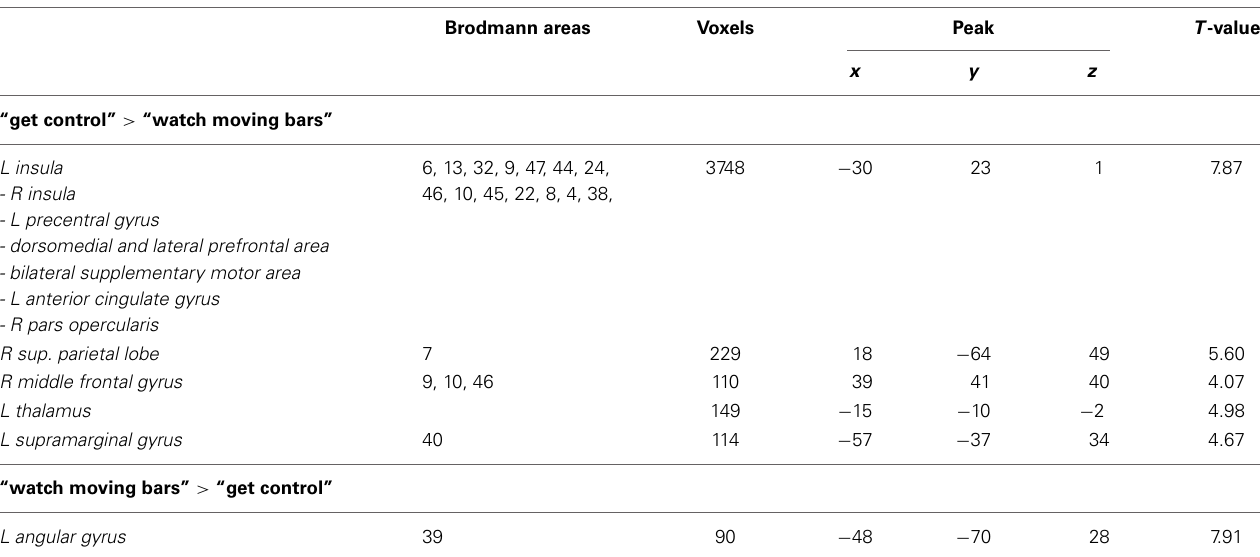
Table 2 | Brain regions preferentially activated when attempting to get control over moving color bars compared to when passively watching the moving color